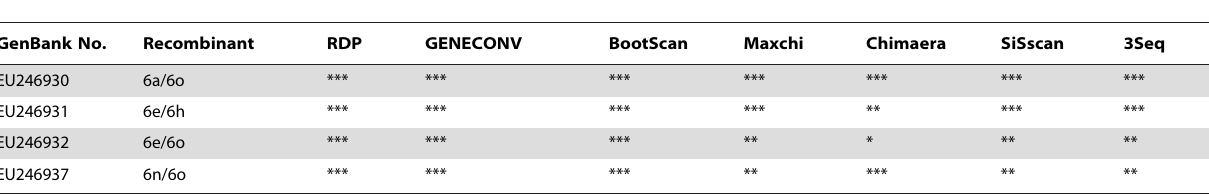
Table 2. Verification of the four novel inter-subtype recombinants by independent methods a .